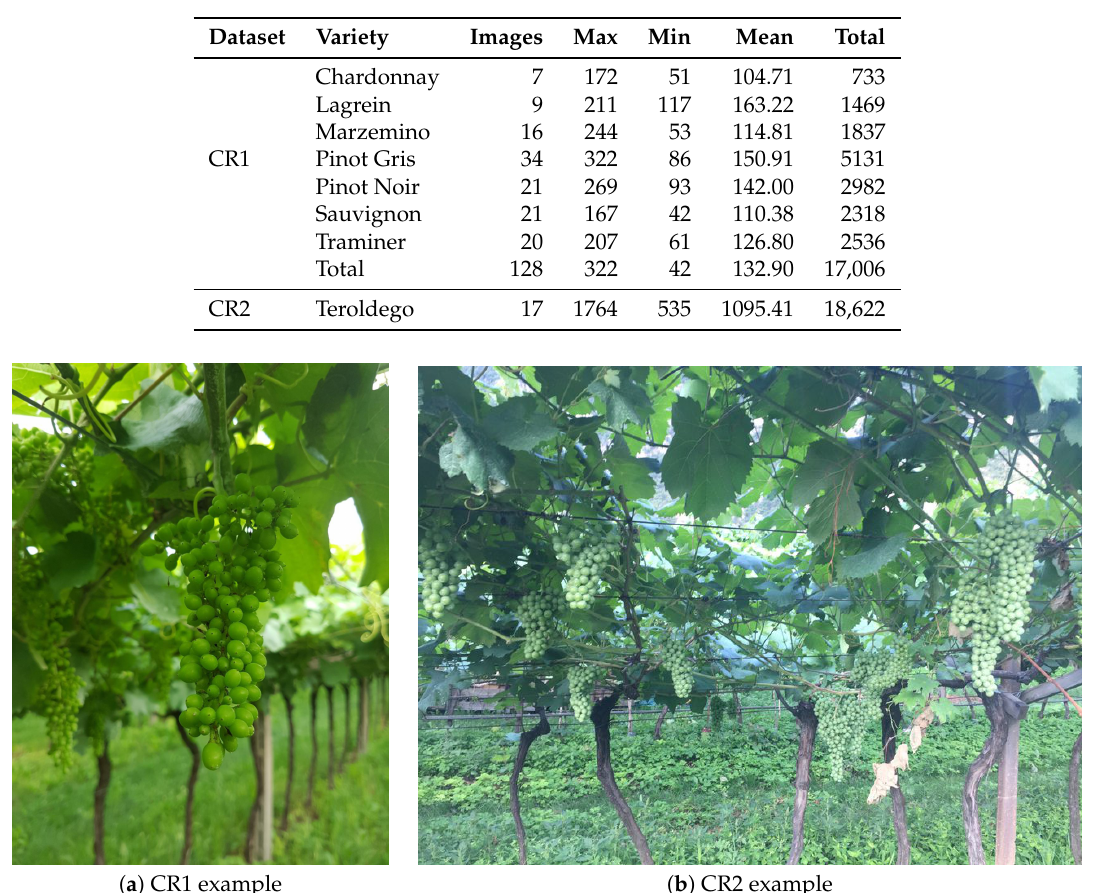
Table 3. Number of annotated berries per image in the CR1 and CR2 datasets.